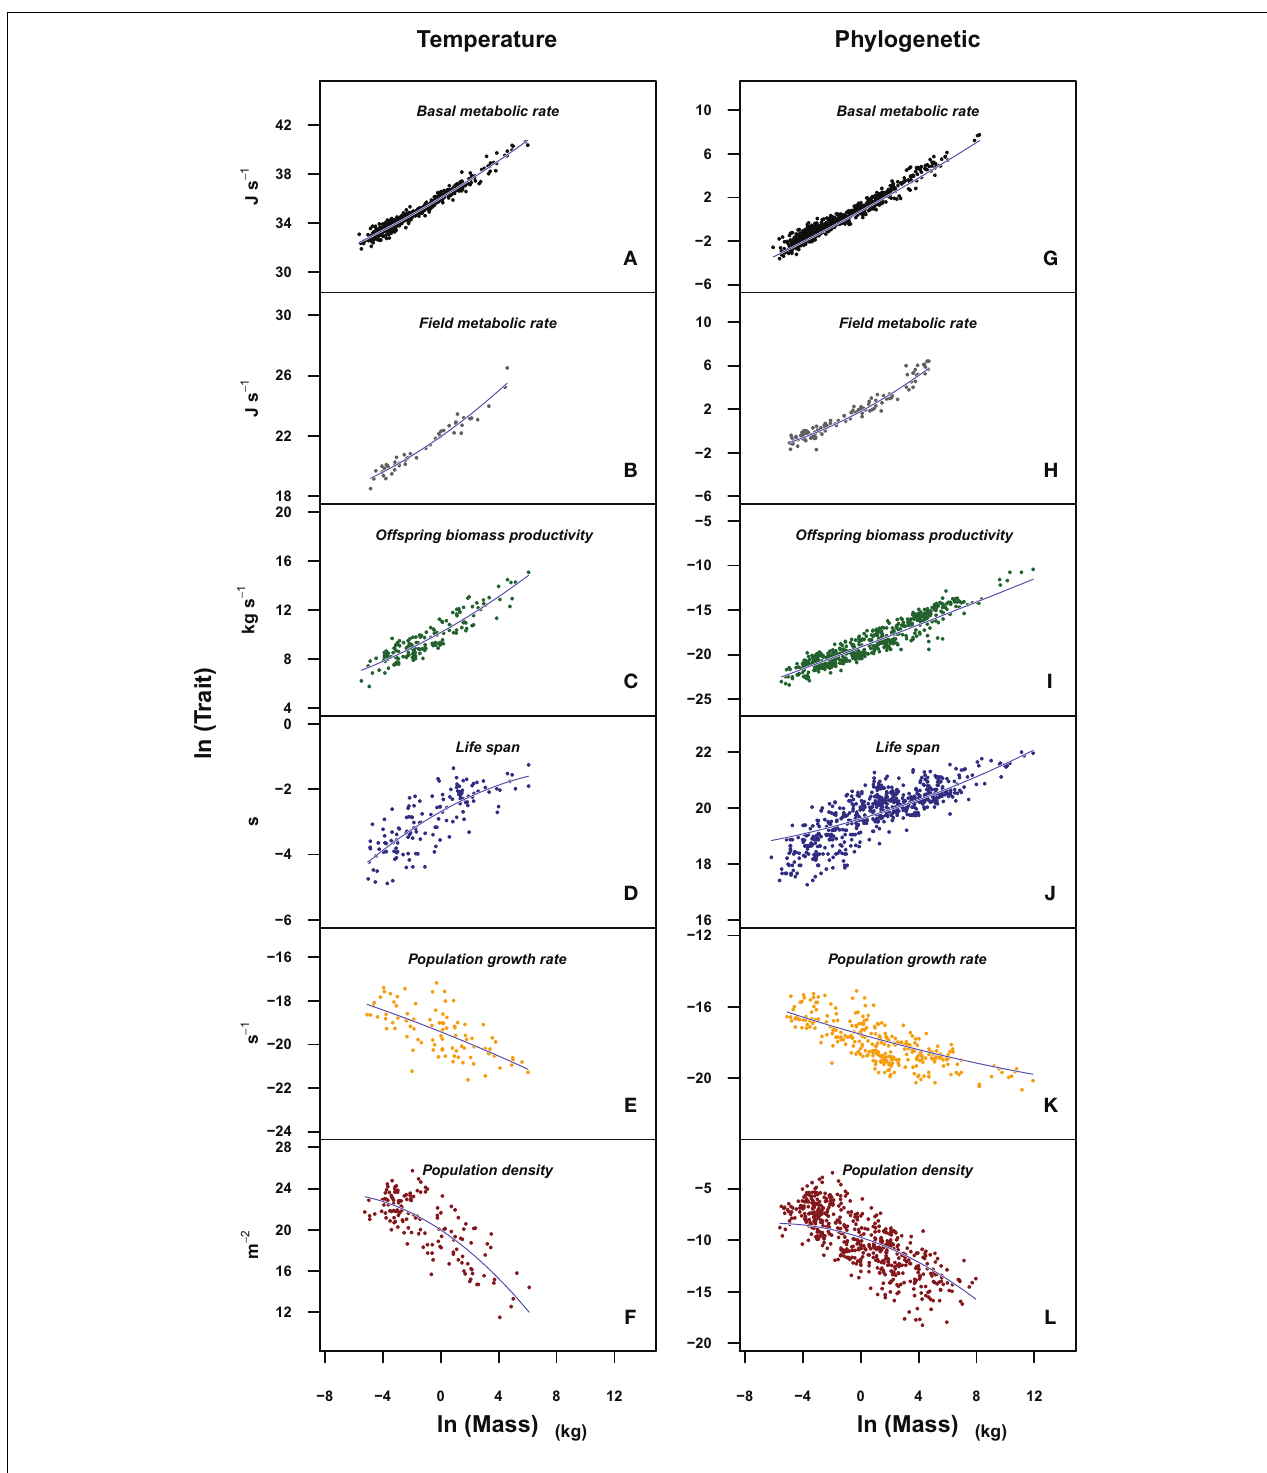
FIGURE 2 | Plots of the different life history traits (A,G: basal metabolic rate; B,H: field metabolic rate; C,I: offspring biomass productivity; D,J: life span; E,K: population growth rate; F,L: population density) vs. body mass in a log-log scale. The models fitted (blue lines) incorporate the effects of temperature (left panels) and phylogeny (right panels) . Traits in left panels were corrected for